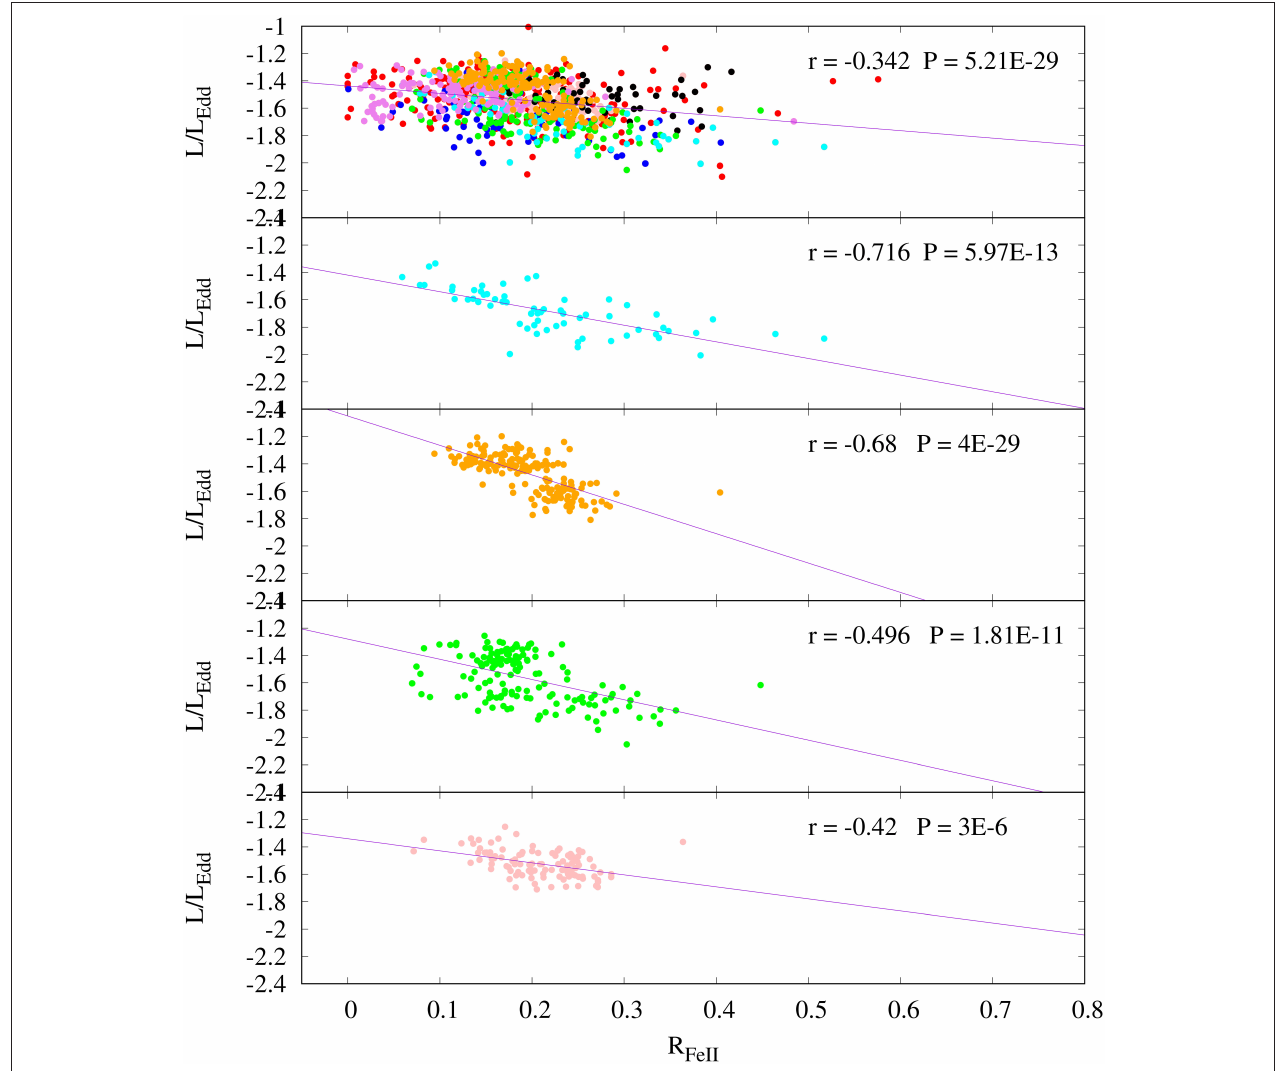
FIGURE 4 | The negative trend: L / L Edd decrease with the increase of R FeII with the time. The strongest anti-correlation was found for well defined time intervals presented on the middle and bottom panel. Colors correspond to those in Figure 1 , 2 .